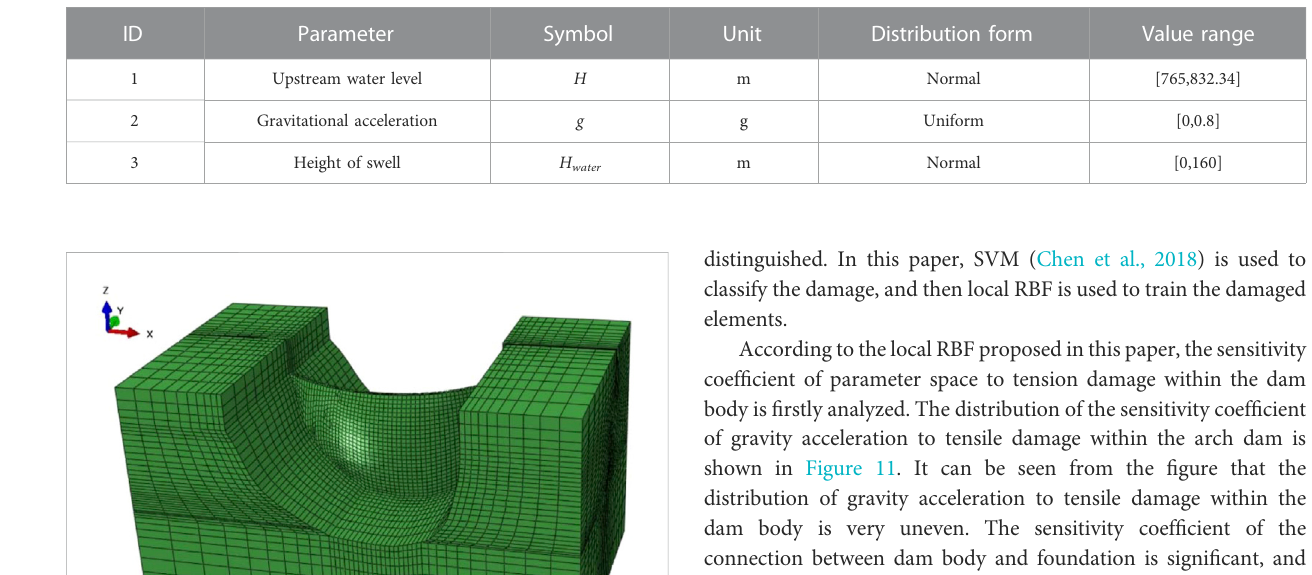
TABLE 2 The probability distribution and value range of the parameters of dynamic behavior surrogate model.